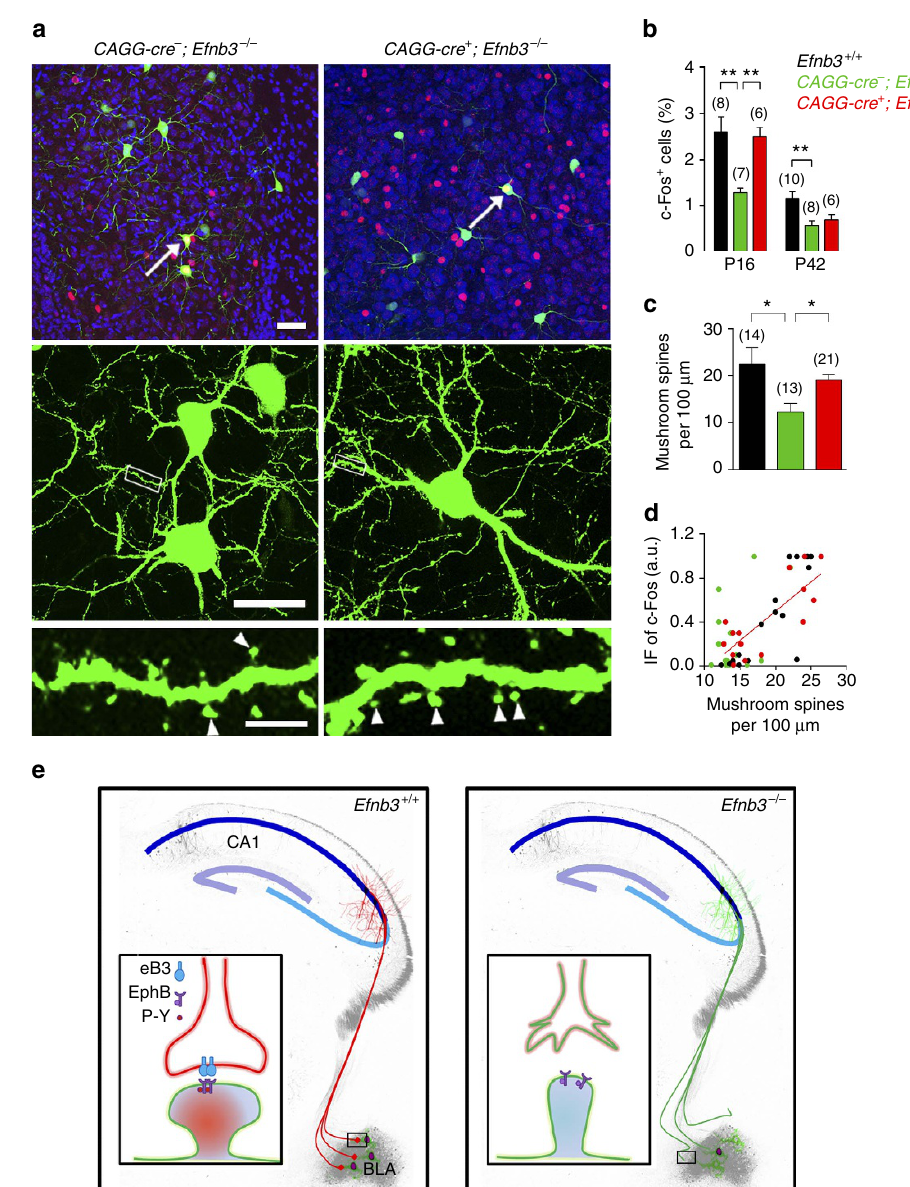
Figure 5 | Time-specific eB3 rescues synaptogenesis and defensive responses in Efnb3 (cid:2) / (cid:2) mutant. ( a ) eB3 rescue improved spine maturation and c-Fos activation in BLA neurons at P16 following tamoxifen administration at P12 in CAGG - Cre þ ; Efnb3 (cid:2) / (cid:2) mice. Scale bars, 40 m m, 25 m m and 5 m m for the upper, middle and lower panels, respectively. ( b ) The percentage of c-Fos-positive cells in BLA in CAGG - Cre þ ; Efnb3 (cid:2) / (cid:2) mice after an EPM trial at P16 increased significantly compared with CAGG - Cre (cid:2) ; Efnb3 (cid:2) / (cid:2) mice following tamoxifen treatment at P12 but not that at P38. n values of mice used are indicated above group bars. ** P o 0.01, one-way ANOVA. ( c ) eB3 rescue increased the density of mushroom spines in BLA neurons at P16 following tamoxifen administration at P12 in CAGG - Cre þ ; Efnb3 (cid:2) / (cid:2) mice. n values of neurons from 5 to 6 mice each group are indicated above each group bar. * P o 0.05, one-way ANOVA. ( d ) Correlation of c-Fos immunofluorescence (IF) and the density of mushroom spines in c-Fos-positive neurons (left panel) in Efnb3 þ / þ , CAGG - cre (cid:2) ; Efnb3 (cid:2) / (cid:2) and CAGG - cre þ ; Efnb3 (cid:2) / (cid:2) mice after EPM trial at P16. n ¼ 18 neurons from 6 mice for Efnb3 þ / þ , r 2 ¼ 0.74; n ¼ 19 neurons from 7 mice for CAGG - Cre (cid:2) ; Efnb3 (cid:2) / (cid:2) , r 2 ¼ 0.23; n ¼ 17 neurons from 6 mice for CAGG - Cre þ ; Efnb3 (cid:2) / (cid:2) , r 2 ¼ 0.65. All the samples were from triplicated experiments. ( e ) Model of timed pre- and post-synaptic coordination for inter-nucleus neuronal connection for defensive neuronal responses. Pre-synaptic eB3 guides hippocampal axon targeting to connect with amygdala neurons through binding with EphB receptors. The eB3-EphB tetramer formation and EphB receptor kinase activation consolidate the trans-nucleus neuronal connection that is required for spinogenesis and threat stimulated defensive responses in BLA neurons. The mushroom spinogenesis and defensive neuronal activity are disrupted in Efnb3 (cid:2) / (cid:2) generated by inserting a loxP -flanked PGK-neo cassette into the intron between the fourth and the fifth exons of Efnb3 that results in a protein-null allele 27 . The primary targeted allele of Efnb3 (cid:2) / (cid:2) homozygote was crossed with CamKII -Cre line/ CAGG -Cre mouse line and a tdTomato reporter mouse line. Endogenous level of eB3 in the initial Efnb3 (cid:2) / (cid:2) mutant was restored on Cre expression that induced excision of the loxP-flanked PGK-neo cassette. All the mice were crossed with the Thy1-GFP M transgenic mouse line. Consecutive backcrosses to the CD1 strain